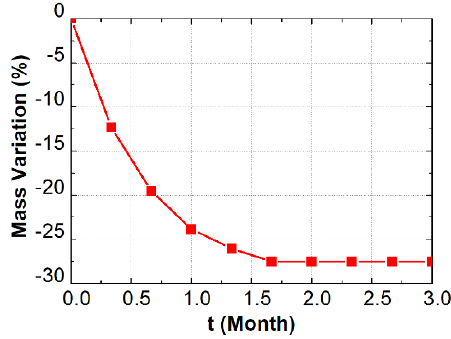
Figure 2. Mass variation of the sample vs. balancing preparation time.